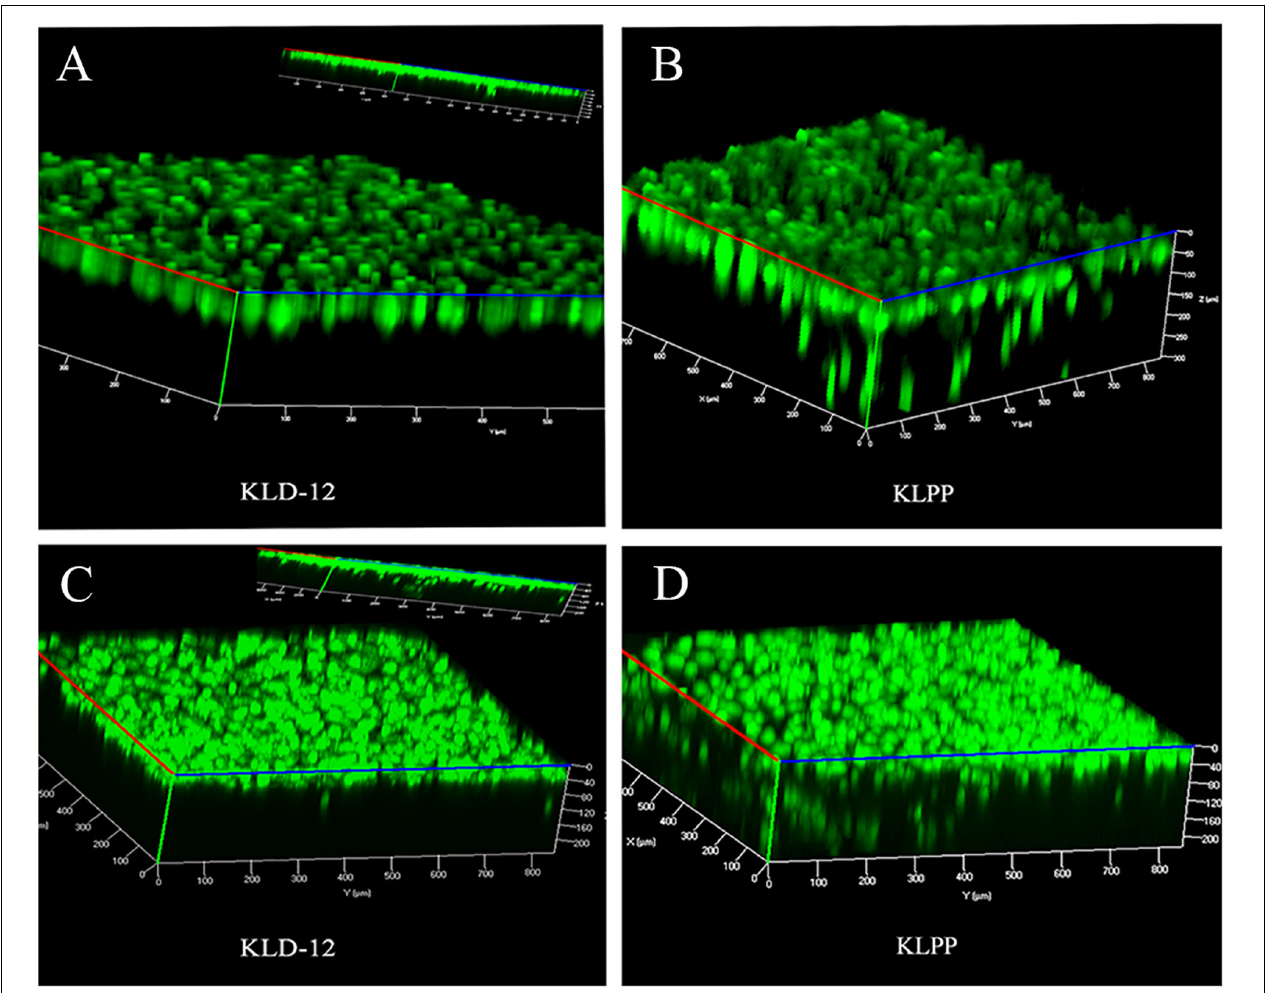
FIGURE 5 | 3D confocal images of chondrocyte (A,B) and BMSC (C,D) migration on day 7. (A,C) KLD-12 hydrogel, (B,D) KLPP hydrogel. KLPP hydrogel significantly induced chondrocyte migration and increased BMSC migration compared to KLD-12 hydrogel. 3D, three-dimensional; BMSC, Bone marrow mesenchymal stem